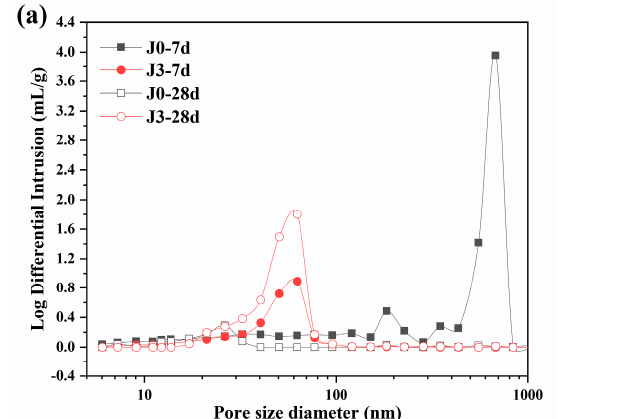
Figure 13. ( a ) Pore size distribution and ( b ) cumulative pore volume of M-S-H cement with SRA under dry conditions.